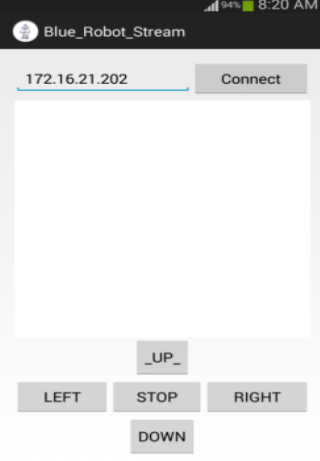
Figure 5. Android application for controlling the master robot.